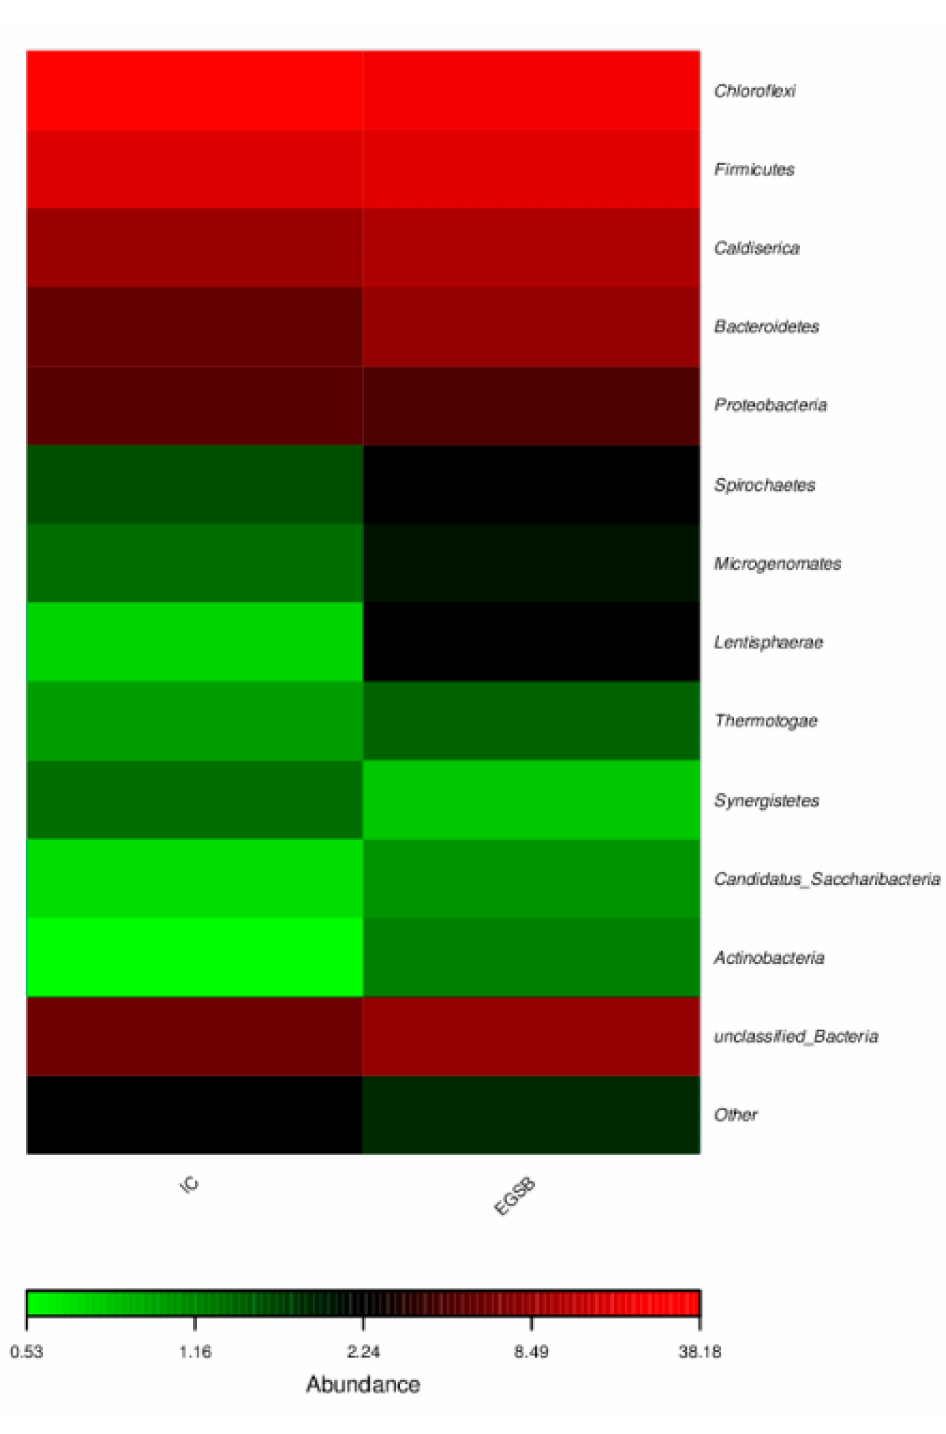
Figure 14. Relative abundance heat